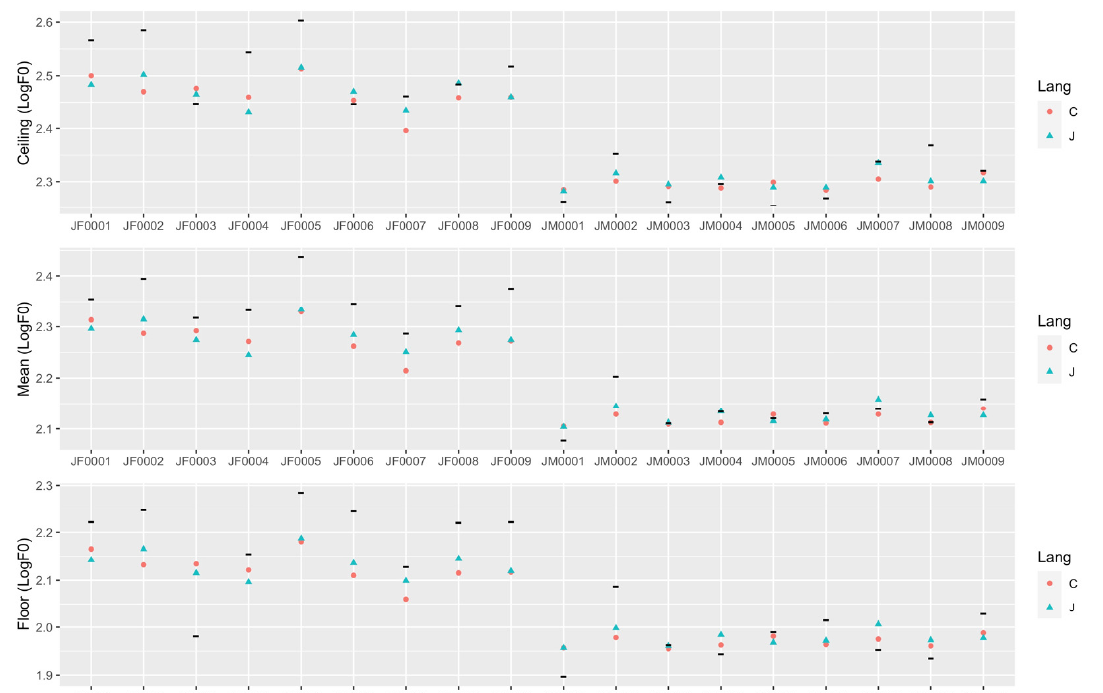
Figure 3. Results of the refined model for the 18 speakers (on the abscissa, where JF and JM indicate female and male Japanese speakers, respectively), with estimates from the Japanese utterances (in triangles) and from the Chinese utterances (in dots). The actual values (in bars) are calculated by direct F0 analysis from all speech data. The three panels from top to bottom indicate the estimates of ceiling, mean and floor, respectively.